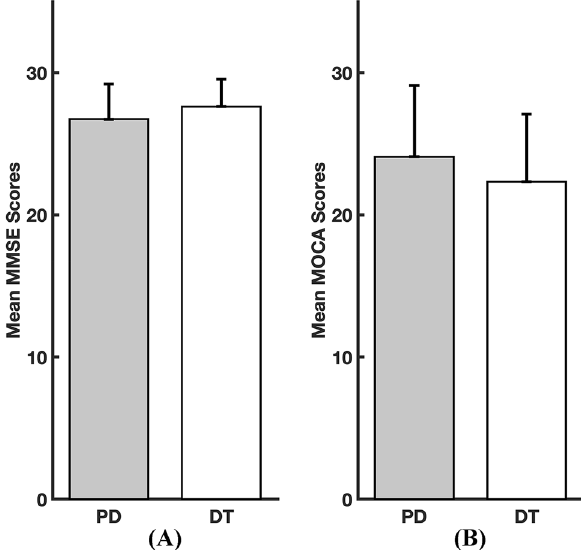
Figure 2. Comparisons of the MMSE scores and the MoCA scores between the PD and DT patients. ( A ) Comparison of mean MMSE scores between the PD patients and the DT patients. ( B ) Comparison of the mean MoCA scores between the PD patients and the DT patients. MMSE Mini-Mental State Examination, MoCA Montreal Cognitive Assessment, PD Parkinson’s disease; DT,